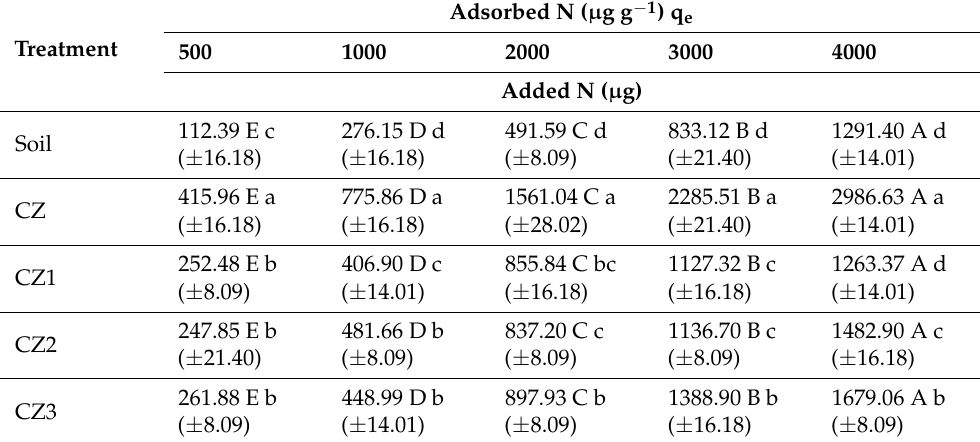
Table 8. Interactive effects of the different nitrogen concentrations and treatments (Soil only, clinop- tilolite zeolite only, and soil with different amounts of clinoptilolite zeolite) on the amounts of nitrogen adsorbed.